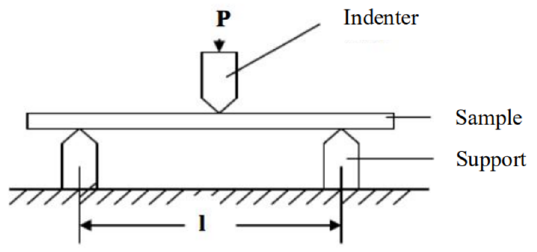
Figure 1. Schematic diagram of bending strength test.